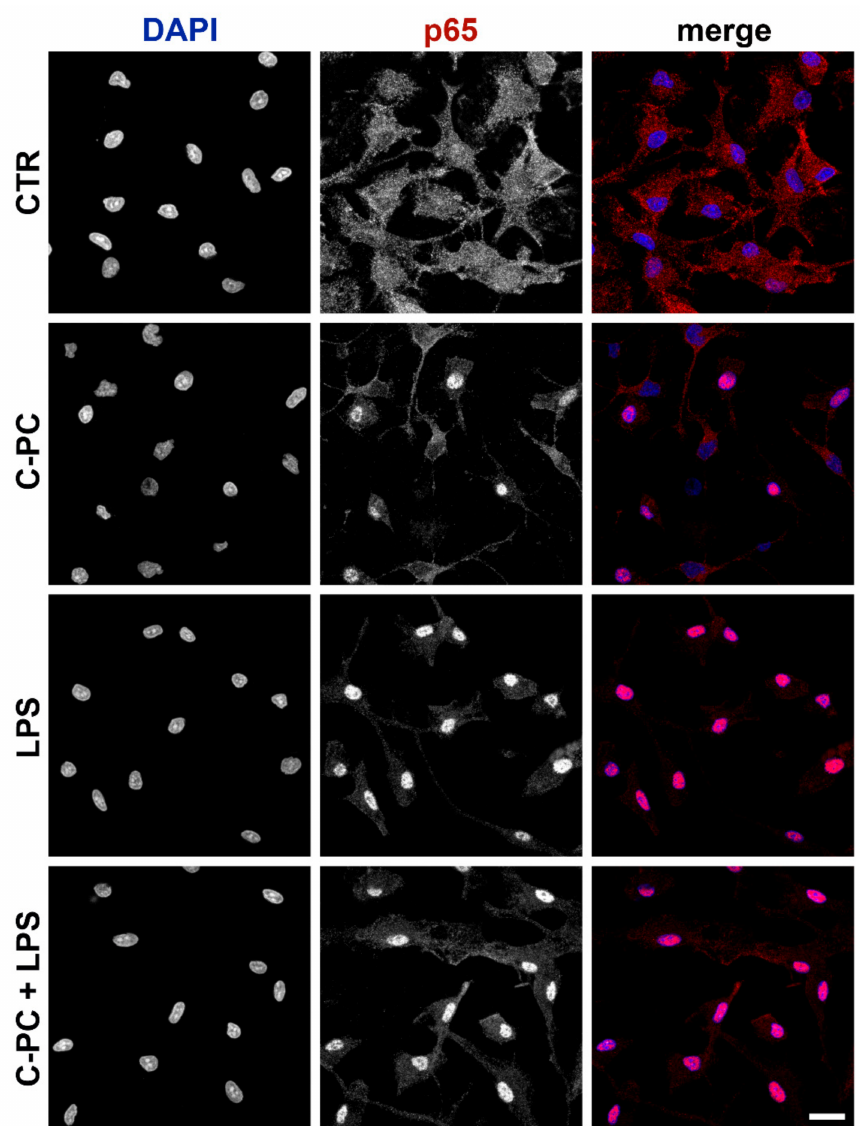
Figure 4. Effect of C-phycocyanin on NF- κ B activation in microglia. Microglia were cultured overnight in medium containing 10% of serum, which was replaced with serum-free medium before treatment with 100 µ g/mL C-PC ± 100 ng/mL LPS. Cells were then processed for NF- κ B p65 immunostaining. Experiments were performed 3 times and representative confocal images showing subcellular localization of p65 are shown. Scale bar, 10 µ